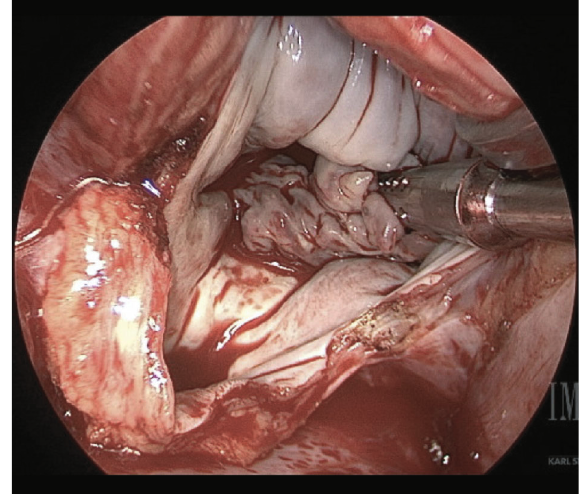
Figure 3: 4 × 1 : 5 cm vegetation resected from the posterior left atrial